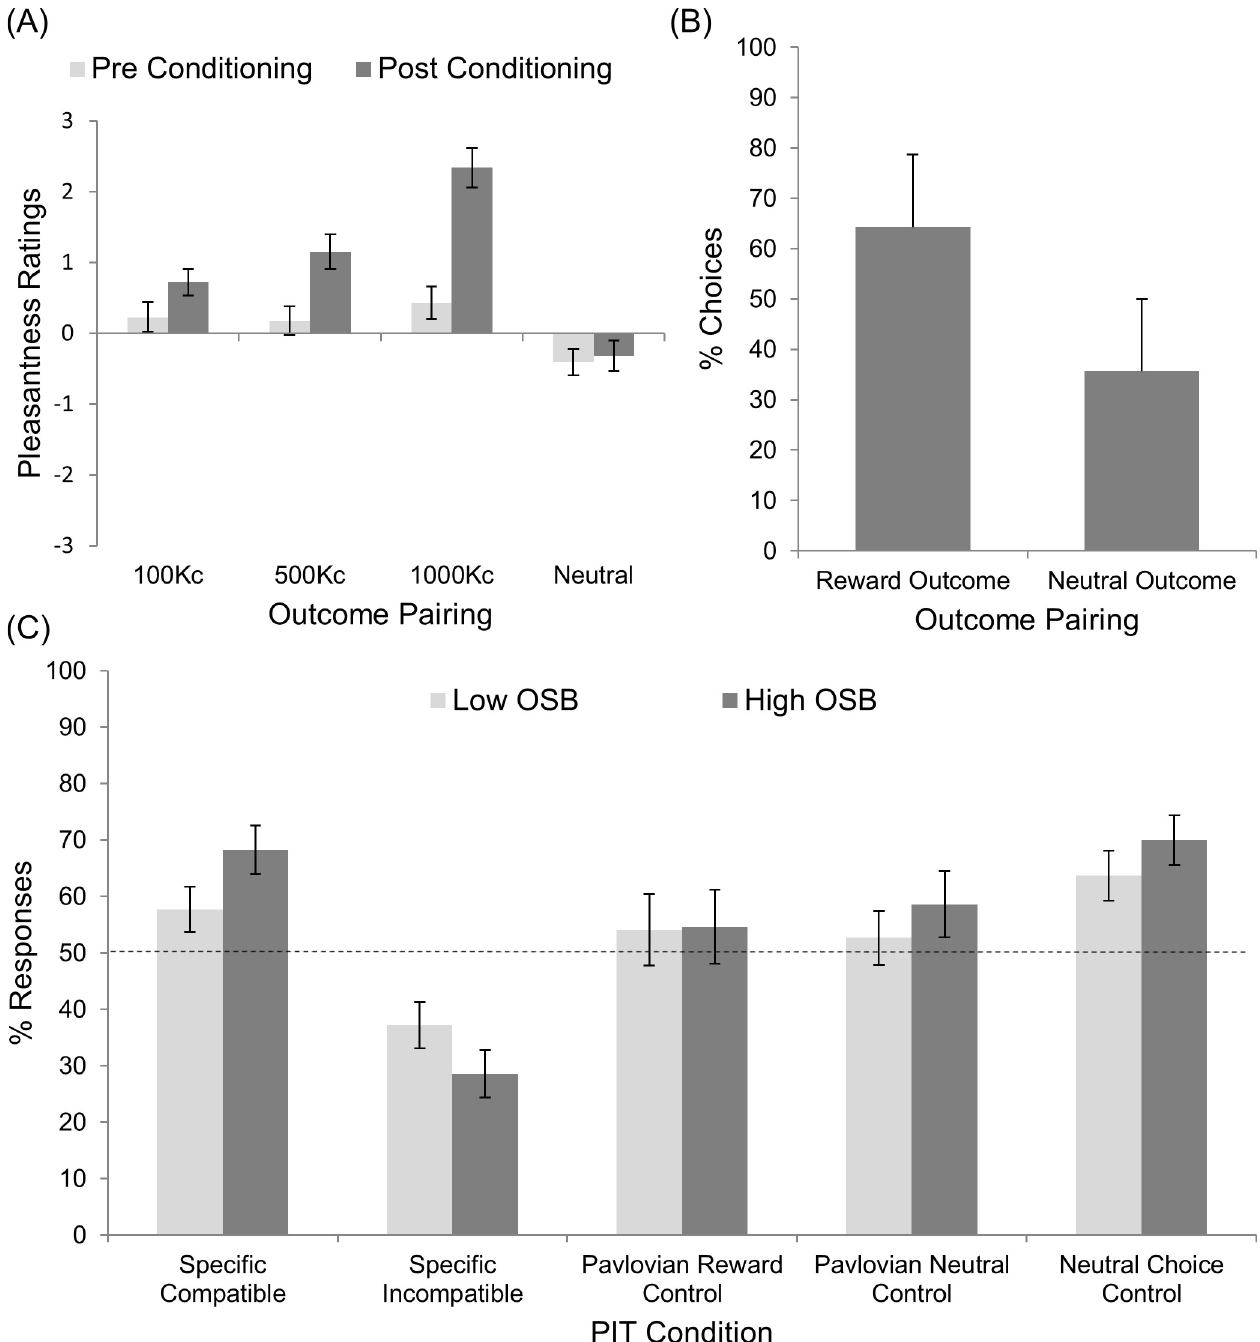
Fig 1. The Pavlovian-to-instrumental transfer (PIT) task. Exemplar stimulus slides for each of the three experimental phases are shown (A) phase 1, Pavlovian conditioning; (B) phase 2, instrumental conditioning; and (C) phase 3, Pavlovian-to-instrumental transfer. Within each experimental phase, time (ms) is represented from top-to-bottom, with timings for stimulus slide presentation shown on the left. The struck banknote in the transfer phase denotes that no monetary or neutral outcome was delivered in this phase.